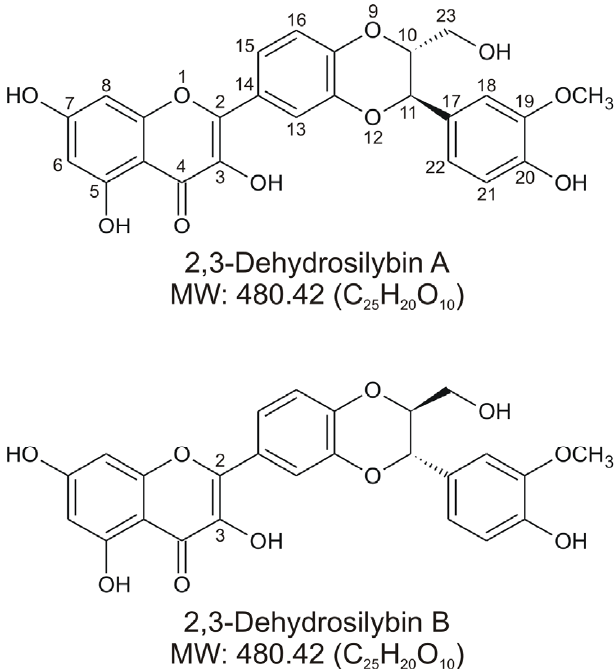
Figure 1. Chemical structures of 2,3 ‐ dehydrosilybin A and 2,3 ‐ dehydrosilybin